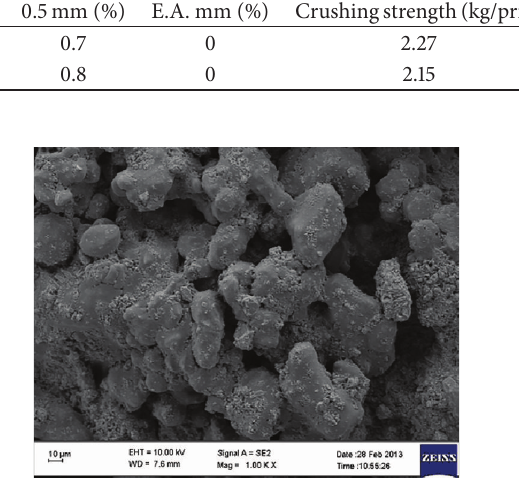
Figure 7: SEM image of ammonium nitrate with 0.1% calcium